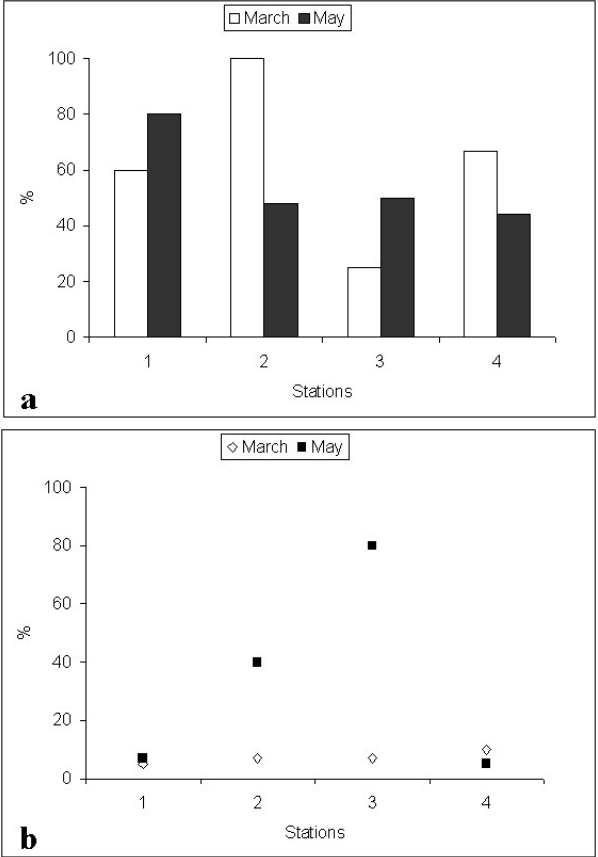
Fig. 9 . Rates of follicular atresia in the ovaries of C. spilopterus captured at Mamanguá Inlet: a) percentage of females present- ing á or older atresia; b) maximum rates of atresia by females in each oceanographic station on March and May